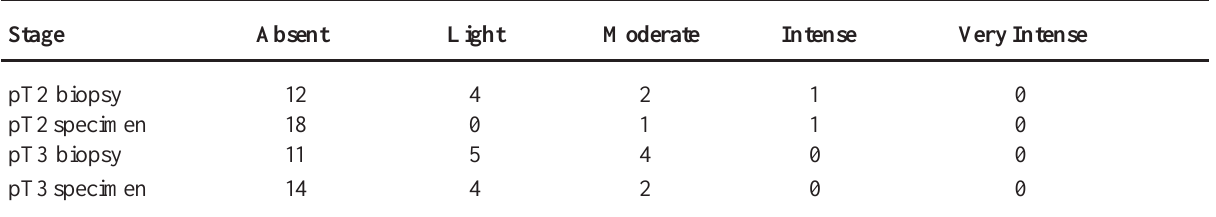
Table 6 – Number of patients grouped in the different categories, based on the chromogranin-A expression in both stages (pT2 and pT3).